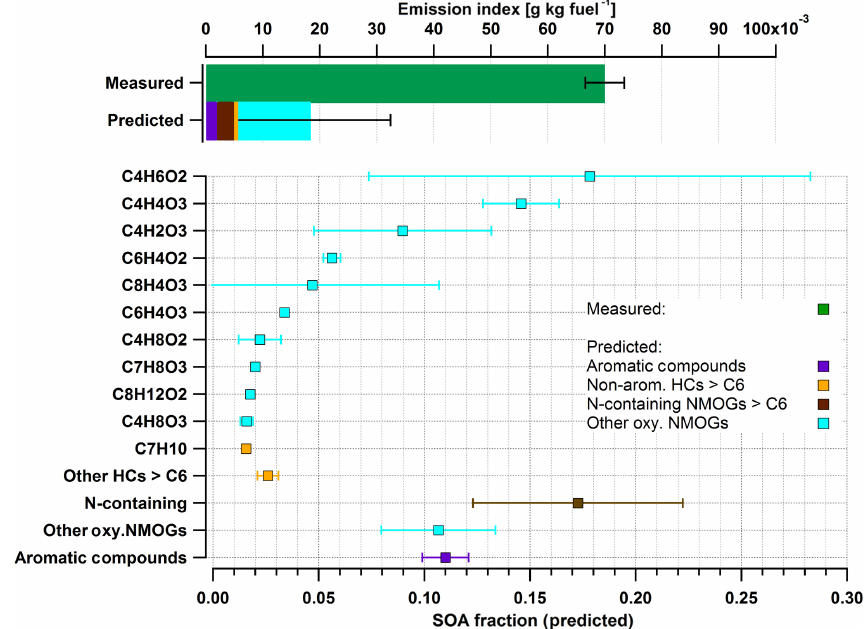
Figure 6. Measured and predicted SOA comparison at an approximated cruise load, using the same approach as in Fig. 5. In contrast to idle conditions, total NMOGs detected do not explain SOA